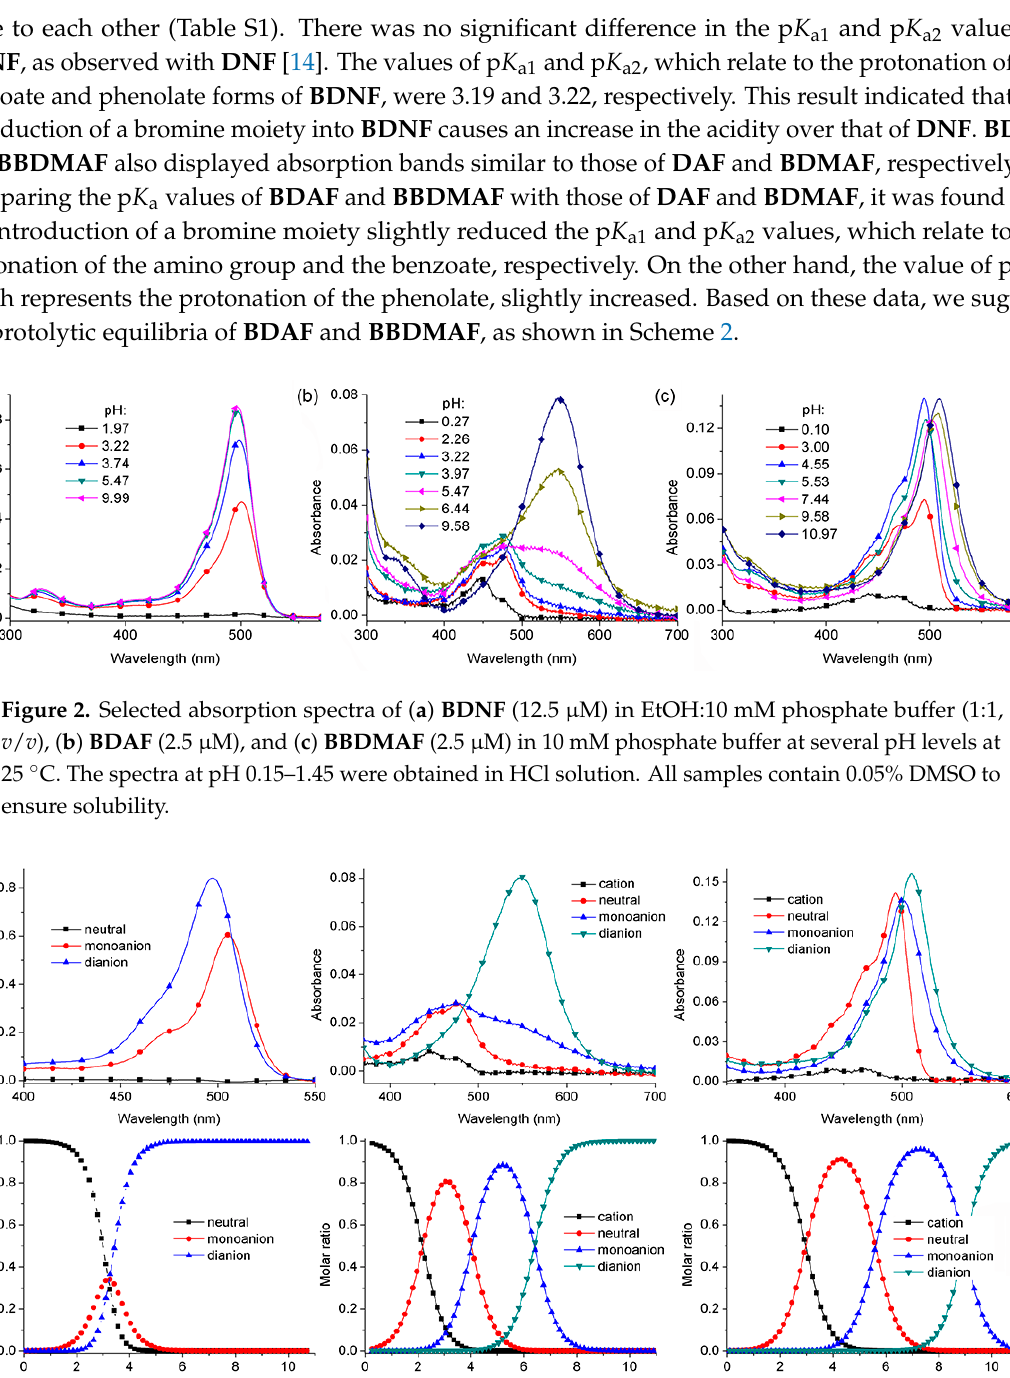
Figure 3. ( a ) Proposed spectra for the protolytic forms (cation, neutral, monoanion, and dianion) of BDNF (left), BDAF (middle), and BBDMAF (right) generated by the DATAN program; ( b ) relative concentration curves for each protolytic species versus pH.